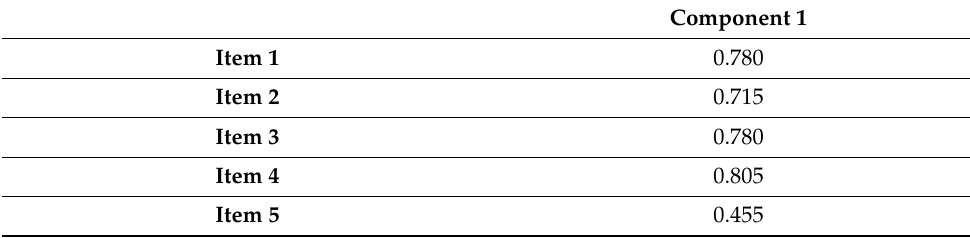
Table 6. Analysis of the extracted principal